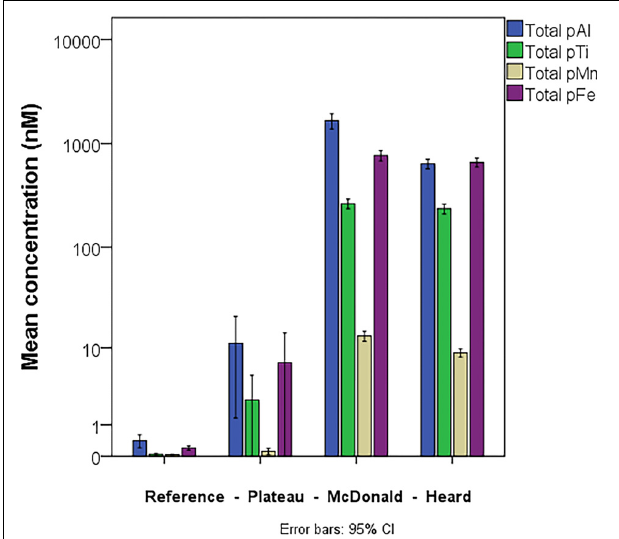
FIGURE 4 | Mean, full water column, total particulate (labile + refractory) Al, Ti, Mn, and Fe within the suspended particles at the four contrasting regions within the study. Error bars represent the 95% confidence interval. The number of independent data points for the reference, plateau, McDonald and Heard regions were 15, 13, 12, and 9,